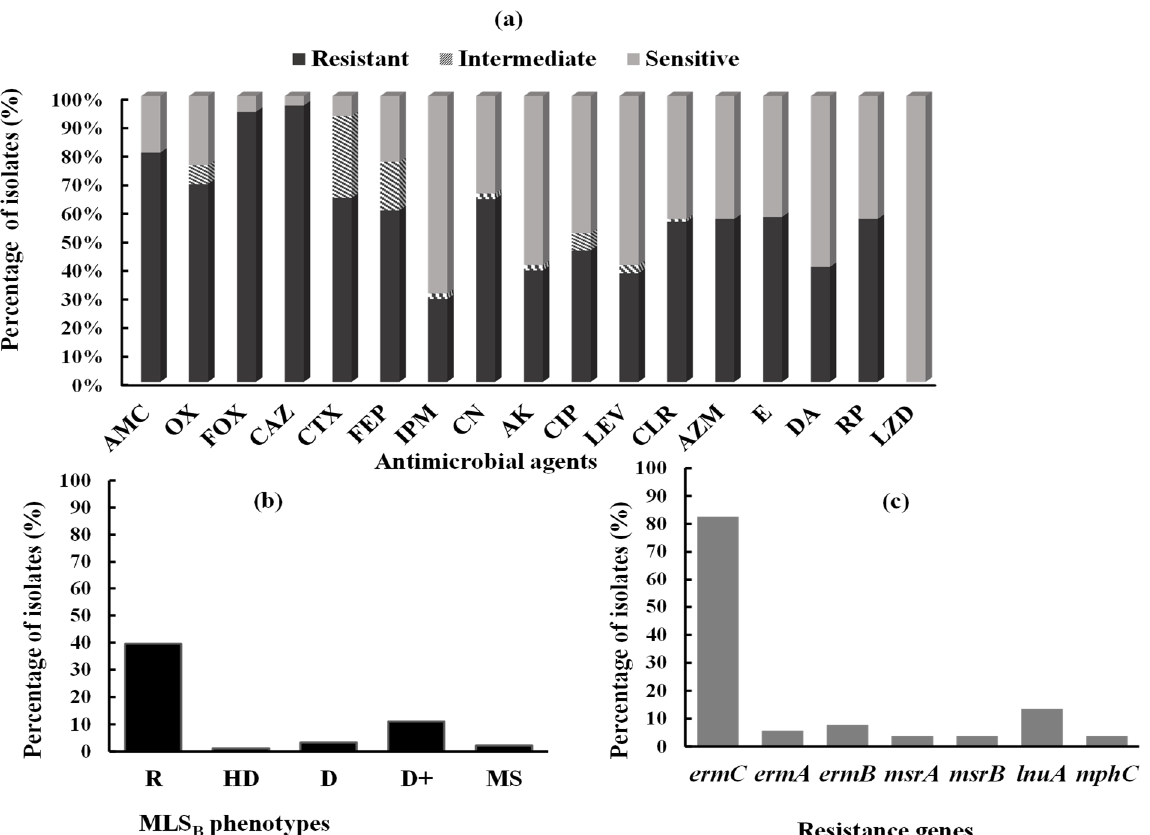
Figure 2. Antimicrobial resistance, phenotypic and genotypic detection of MLS B determinants. ( a